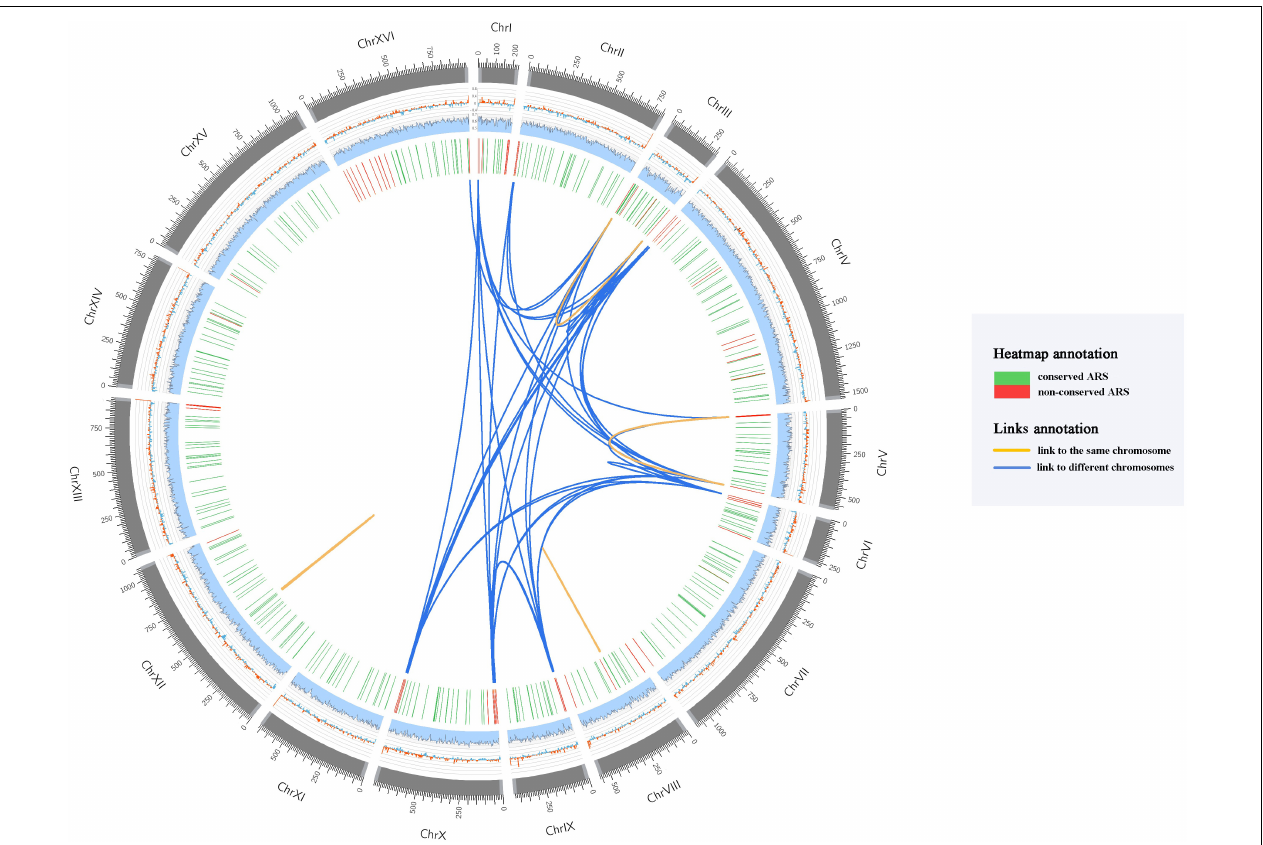
FIGURE 1 | Circos plot showing the ARSs distribution of S. cerevisiae S288C reference genome. Every circle is described in the outermost-innermost direction. (1) The outermost circle represents the S. cerevisiae S288C chromosomes in kb, and the subtelomeric regions are colored in lighter gray; (2) GC-skew (window=3 kb, step=3 kb); (3) AT content (window=3 kb, step=3 kb); (4) Conservation heatmap of 352 ARSs. The location of each bar in the heatmap denotes the position of the ARS in each chromosome of S. cerevisiae S288C, and the number of homologous ARSs in 104 yeast strains is represented by the color of green (conserved